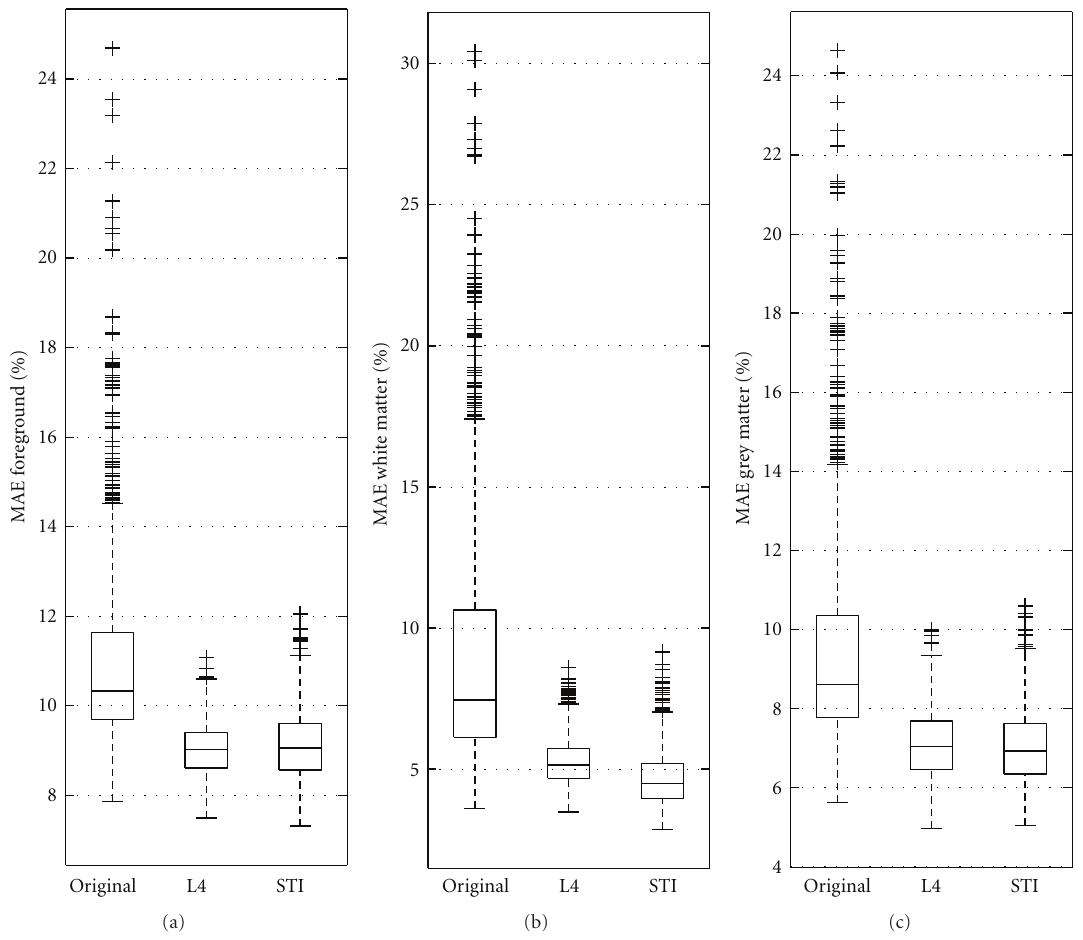
Figure 5: Boxplots of MAE obtained over the 795 images of the ADNI dataset for (a) FRG, (b) WM, and (c) GM. (Original) Nonlinearly registered input images, (L4) nonlinearly registered output images standardized with L 4 , (STI) nonlinearly registered output images standardized with STI.